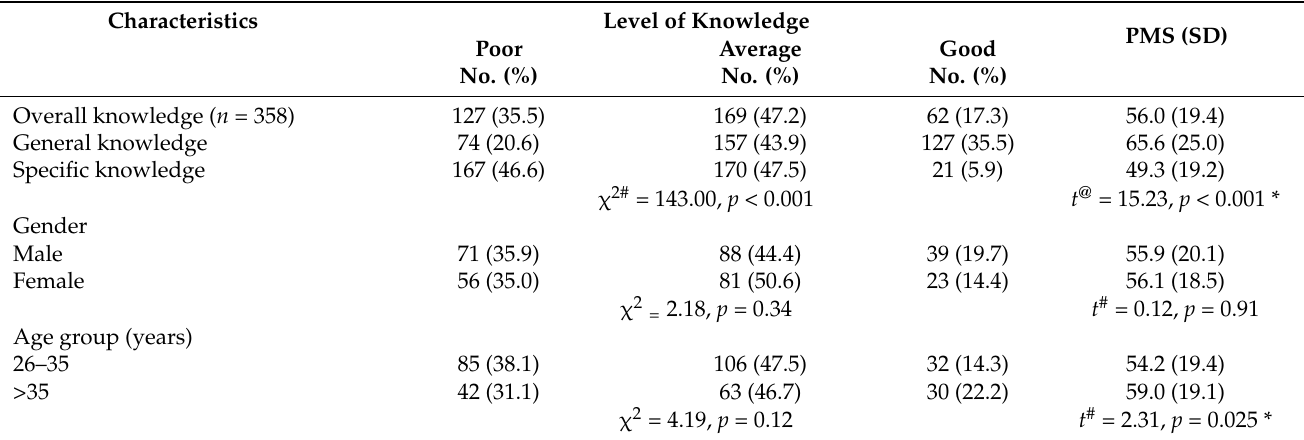
Table 3. Levels of knowledge of physicians on OSA and the role of dentists in management according to some personal